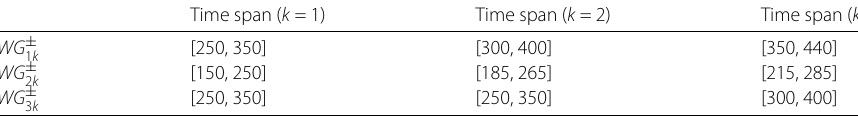
Table 1 Waste generation data (in tonnes/day)